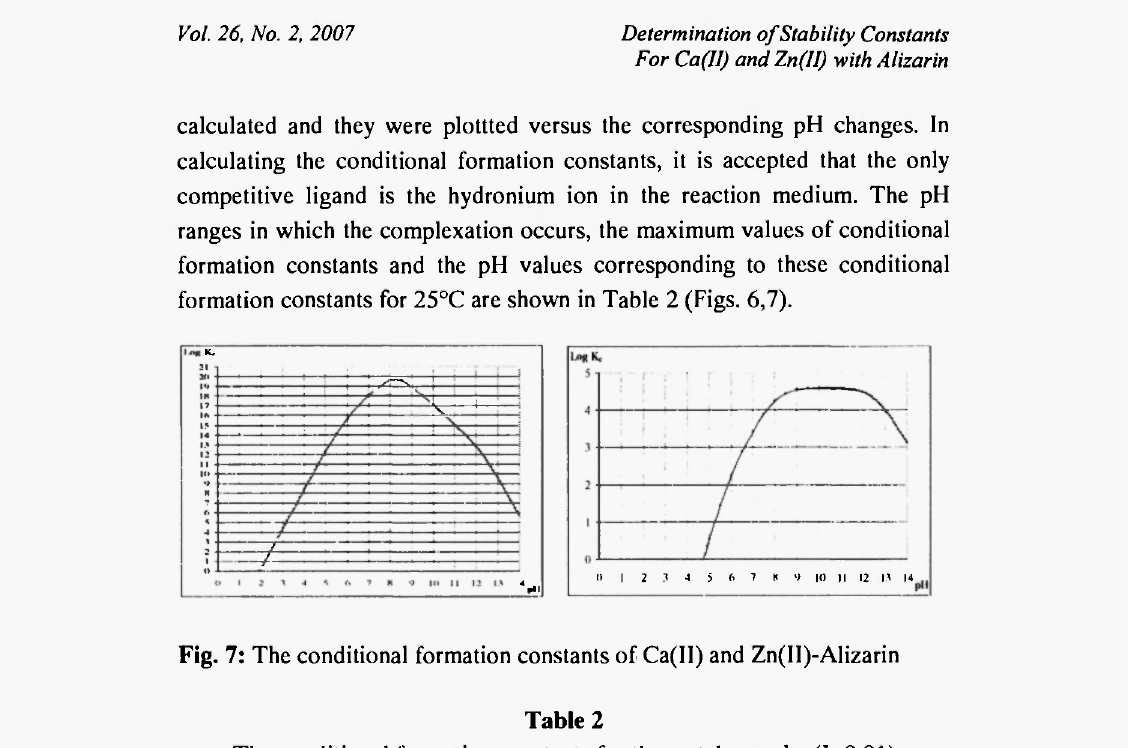
The conditional formation constants for the metal complex(I=0,01) Metal-ligand